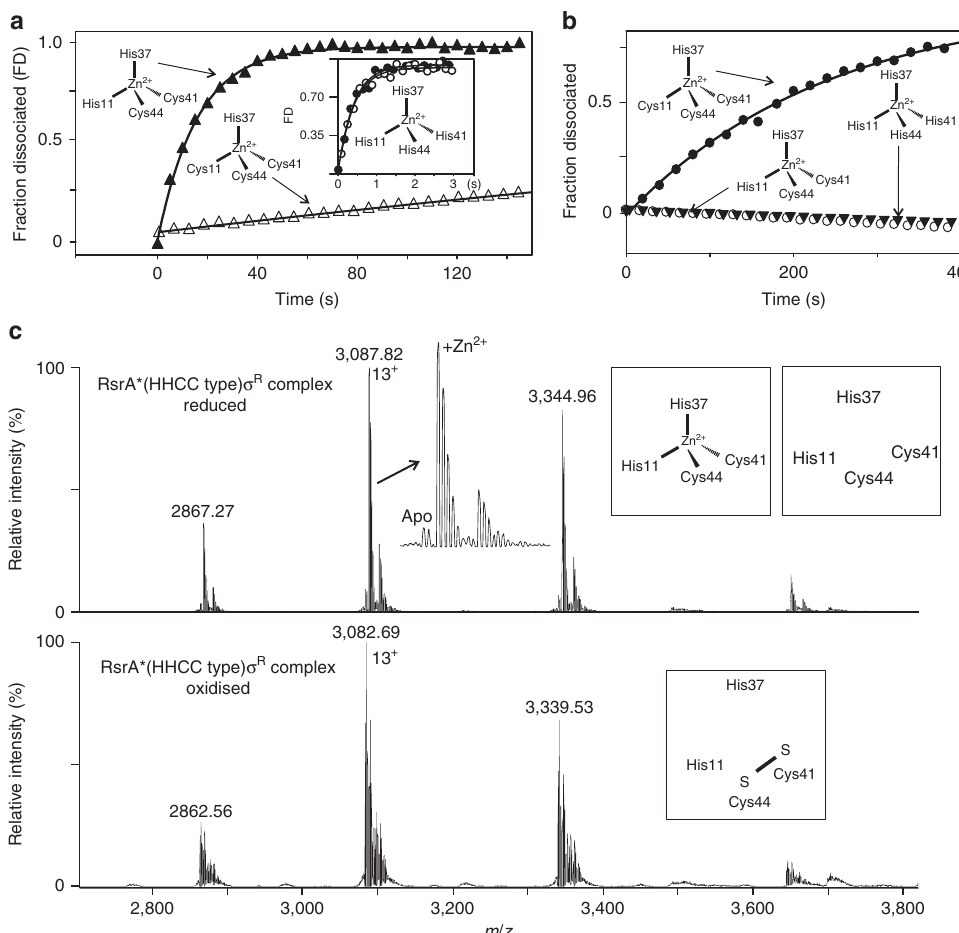
Figure 5 | Cys11 is essential for redox sensing in RsrA. Zinc ligation for each RsrA construct used is shown as a schematic. ( a ) Comparing the intrinsic dissociation rates of s R complexes with RsrA* red .Zn 2 þ (open triangles; k off ¼ 0.0027s (cid:2) 1 ) and RsrA* red .Zn 2 þ Cys11His (closed triangles; k off ¼ 0.064s (cid:2) 1 ) obtained by competition stopped-flow tryptophan emission fluorescence using a 10-fold excess of s R Trp88Ile Trp119Ile. All experiments were conducted at 25 (cid:2) C in 50mM Tris (pH 7.5) buffer containing 100mM NaCl. Inset: dissociation data in the presence (closed circles) and absence (open circles) of zinc for s R in complex with triple mutant RsrA* Cys11His Cys41His Cys44His ( k off B 2.3s (cid:2) 1 ). ( b ) Comparison of H 2 O 2 (10mM)-induced dissociation of the RsrA* red .Zn 2 þ – s R complex (closed circles) with RsrA* red .Zn 2 þ Cys11His– s R (open circles) and RsrA* red .Zn 2 þ Cys11His Cys41His Cys44His (closed triangles) complexes. Data for complexes of RsrA* Cys41His and RsrA* Cys44His, shown in Supplementary Fig. 4, were essentially identical to RsrA*. The absence of Cys11 renders RsrA insensitive to oxidation-induced dissociation from its complex with s R . ( c ) Upper panel: native state mass spectrometry data for RsrA* red .Zn 2 þ Cys11His in complex with s R showing the predominance of the zinc-bound species (theoretical/observed mass, 40,128.08/ 40,127.54 ± 0.12Da, respectively). The minor species was the reduced complex without zinc bound (theoretical/observed mass, 40,064.72/ 40,064.41 ± 0.66Da, respectively). Lower panel: the same complex following treatment with 10mM H 2 O 2 . Although RsrA* Cys11His remains in complex with s R the metal ion has dissociated and the remaining cysteines (Cys41 and Cys44) have formed a disulfide bond, as deduced by the B 2Da reduction in mass (theoretical/observed mass, 40,062.70/40,061.96 ± 0.28Da,